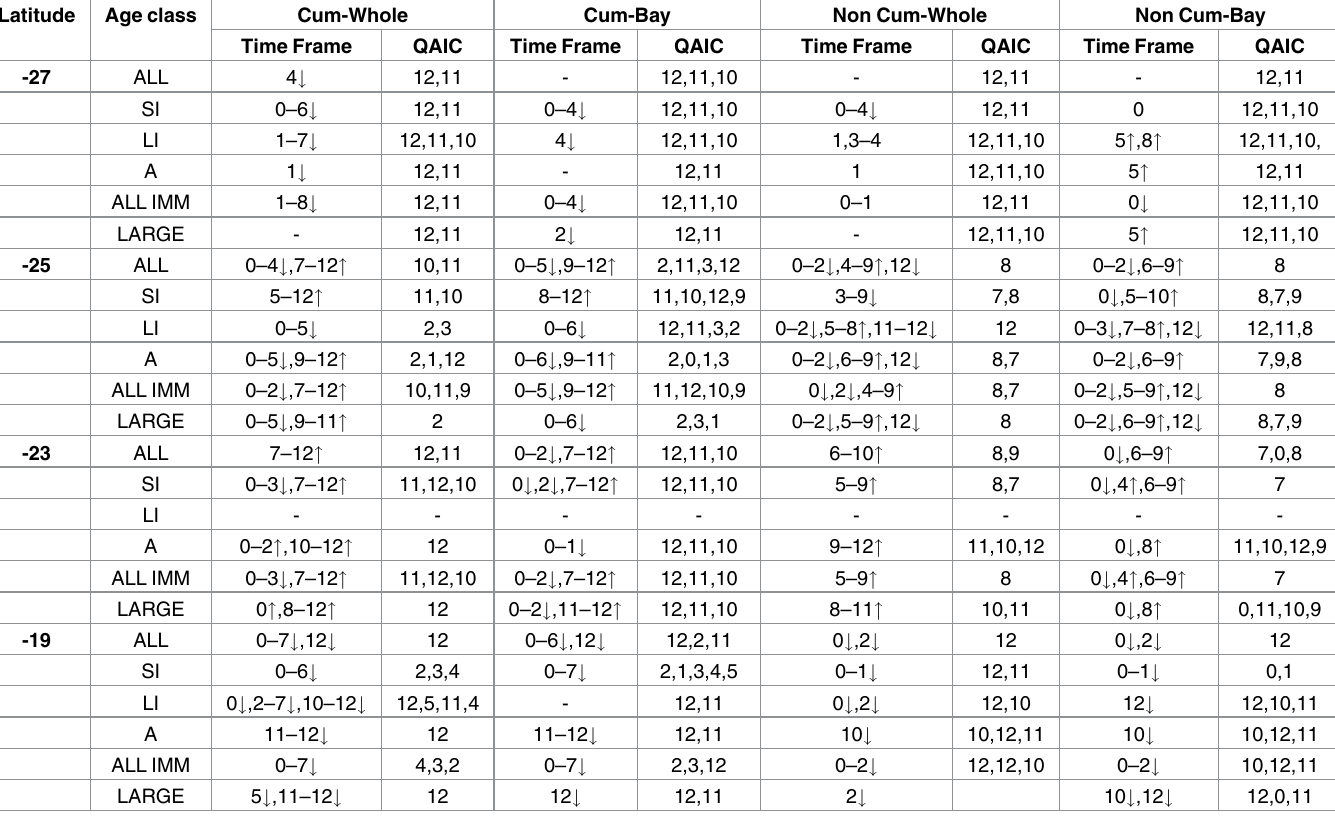
Table 9. Model results for all turtles and rainfall. " denotesincreasedstrandingsrates with increasedrainfall. # denotesdecreasedstranding rates with increasedrainfall. Age class abbreviations: ALL = all turtles, SI = small immature, LI = large immatures, A = adult-sized, ALL IMM = all immature sized animals (small + large),Large = all large turtles (large immatures+ adult-sized). The time frame is reportedin monthlyrangeswhere responses were noted.The values reportedin qAIC are the months with the most significantqAIC